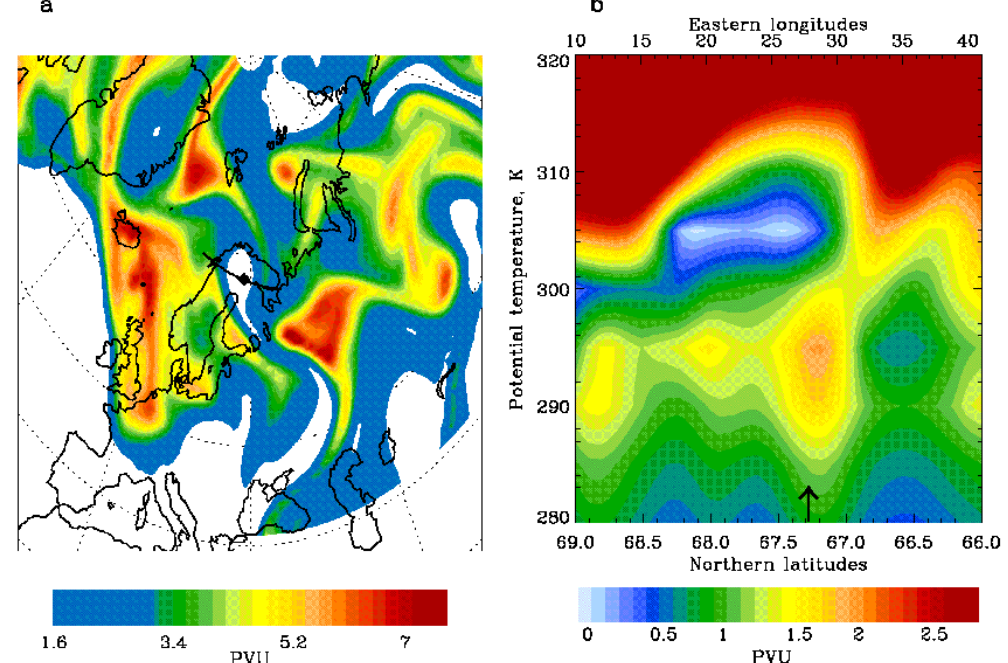
Fig. 7. (a) PV chart for 310K at 12:00UTC on 16 February. Sodankyl¨a is marked with a diamond. Only PV > 1.6PVU is coloured (b) Cross section of PV along the black line from (a) across the tropospheric filament. The station is marked with an arrow.